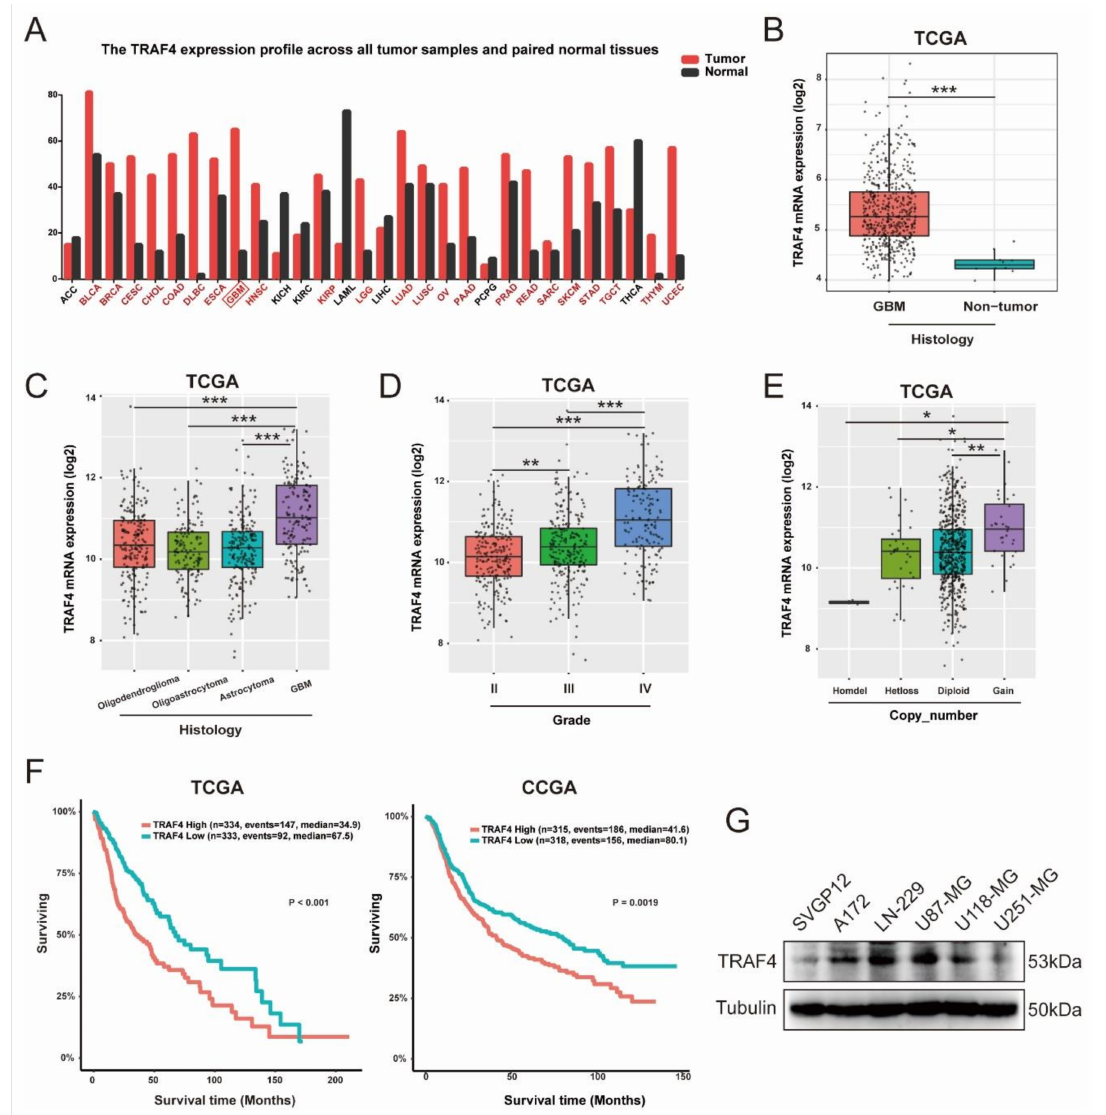
Figure 1. TRAF4 is highly expressed in glioblastoma and predicts poor prognosis. ( A ) Expression of TRAF4 in tumor samples and paired normal tissues was obtained from the GEPIA database. ( B ) Expression of TRAF4 in glioblastoma and non-tumor was obtained from the TCGA database. Box plot of TRAF4 expression with the log-rank test p -values indicated. ( C – E ) Box plot of TRAF4 expression levels by grade, histological subtype, and copy number in glioma set with log-rank test p -values indicated. ( F ) The TCGA and CGGA glioma databases were used to examine the correlation of TRAF4 expression with patient prognosis. ( G ) TRAF4 expression in normal astroglia cell (SVGP12) and glioblastoma cell lines (A172, LN-229, U87-MG, U118-MG, and U251-MG) were detected by Western blotting. All data represent the mean ± SD from at least three independent